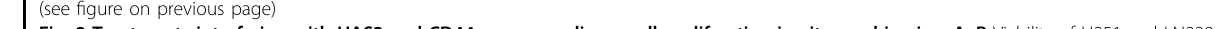
Fig. 2 Treatments interfering with HAS3 and CD44 suppress glioma cell proliferation in vitro and in vivo. A – B Viability of U251 and LN229 glioma cells transfected with the HAS3 siRNA or treated with a CD44 antibody for 48h. C Viability of U251 glioma cells transfected with the HAS3 siRNA or cultured with a CD44 antibody (6µg/ml), followed by treatment with HA (25µg/ml) for 48h. D Levels of the Ki67 protein in LN229 glioma cells were detected using immuno fl uorescence staining after transfection with the HAS3 siRNA or treatment with a CD44 antibody for 48h. Scale bar: 50 μ m. E Representative images of IHC staining for HA in orthotopic xenograft tumors from the control and lentivirus HAS3 siRNA stably transfected glioma cell groups. Representative images of IHC staining for Ki67 in orthotopic xenograft tumors from the control and lentivirus HAS3 siRNA or lentivirus CD44 siRNA stable transfection glioma cell groups. Scale bar: 50 μ m. F – G Representative MRI of orthotopic xenograft tumors and survival curves of the control and lentivirus HAS3 shRNA or lentivirus CD44 shRNA stably transfected glioma cell groups. P1: P-value for the comparison of shNC and shHAS3, P2: P -value for the comparison of shNC with shCD44. LV-shNC: negative control lentivirus, LV-shHAS3: HAS3-knockdown lentivirus. LV- shCD44: CD44- knockdown lentivirus. The data are presented as the mean ± SD; * P < 0.05, ** P < 0.01, and *** P < 0.001, **** P <